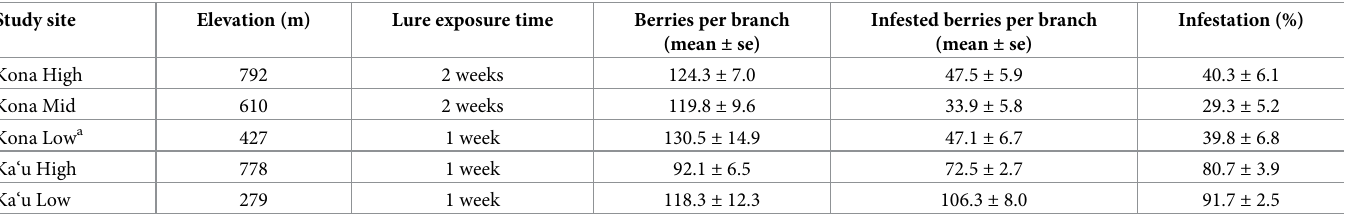
Table 1. Summary of infestation results using 3:1 methanol/ethanol lures hung from 10 selected branches per study site. Lures were left on branches for 1–2 weeks in order to attain sufficient numbers of infested berries per branch ( � 32). Study site Elevation